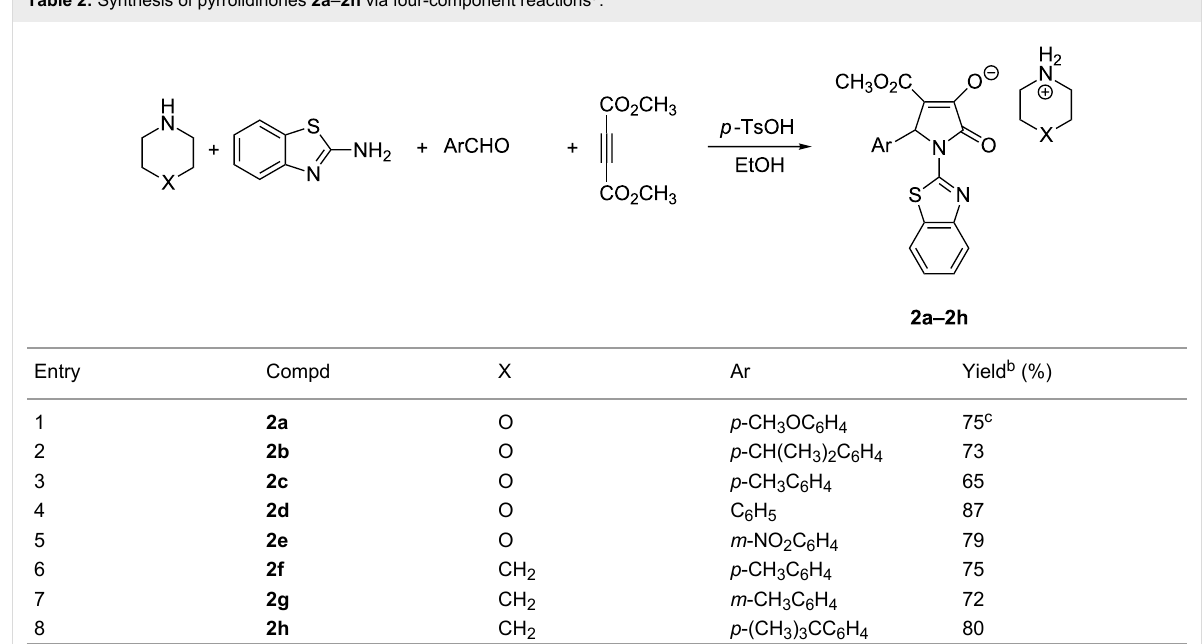
Table 2: Synthesis of pyrrolidinones 2a – 2h via four-component reactions a .